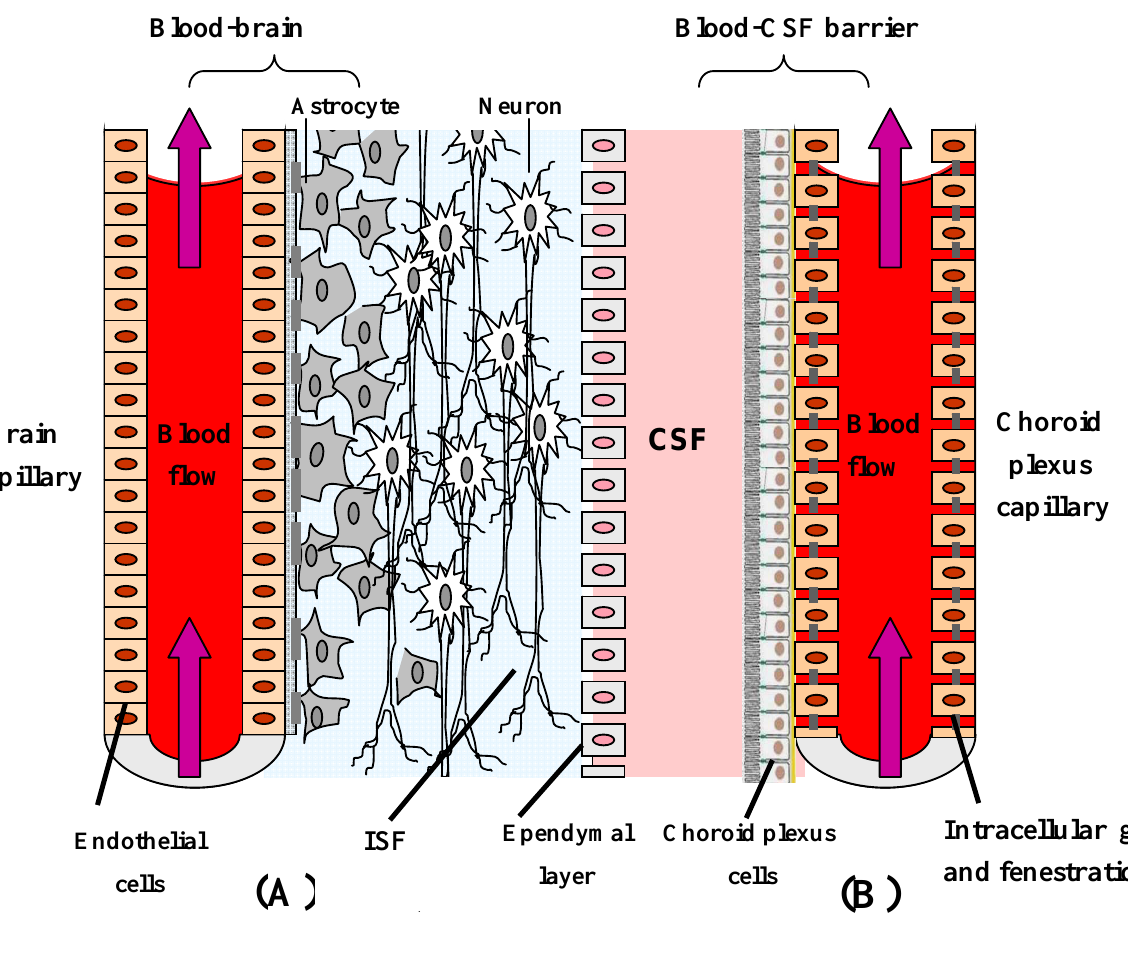
Figure 1. The two main barriers in the CNS: blood-brain barrier (A) and blood- cerebrospinal fluid barrier (B). ISF: Interstitial Fluid. CSF: Cerebrospinal